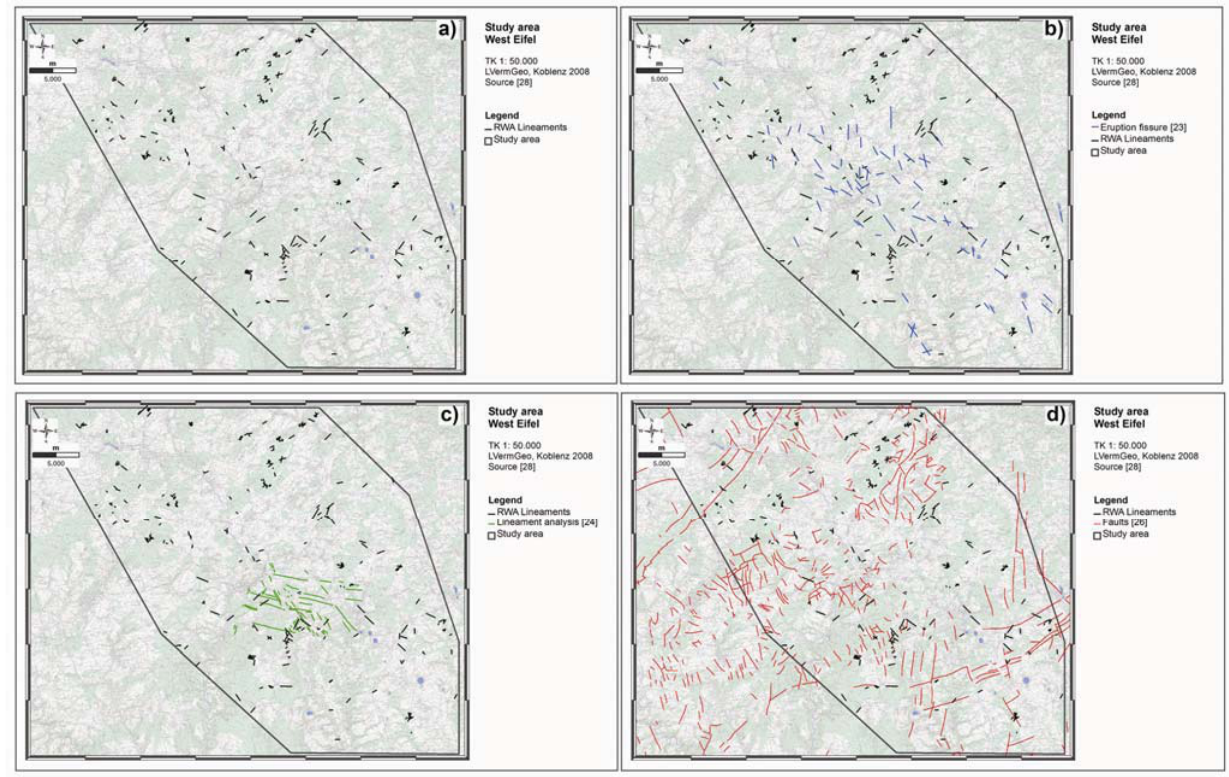
Figure 12. RWA Lineaments (grey lines) ( a ) combined with published tectonic features like Quaternary eruption fissures (blue lines) ( b ), lineament analyses of tectonically active faults (green lines) ( c ) and fault systems (red lines) ( d ) without any differentiation between inactive and active fault systems, for the entire study